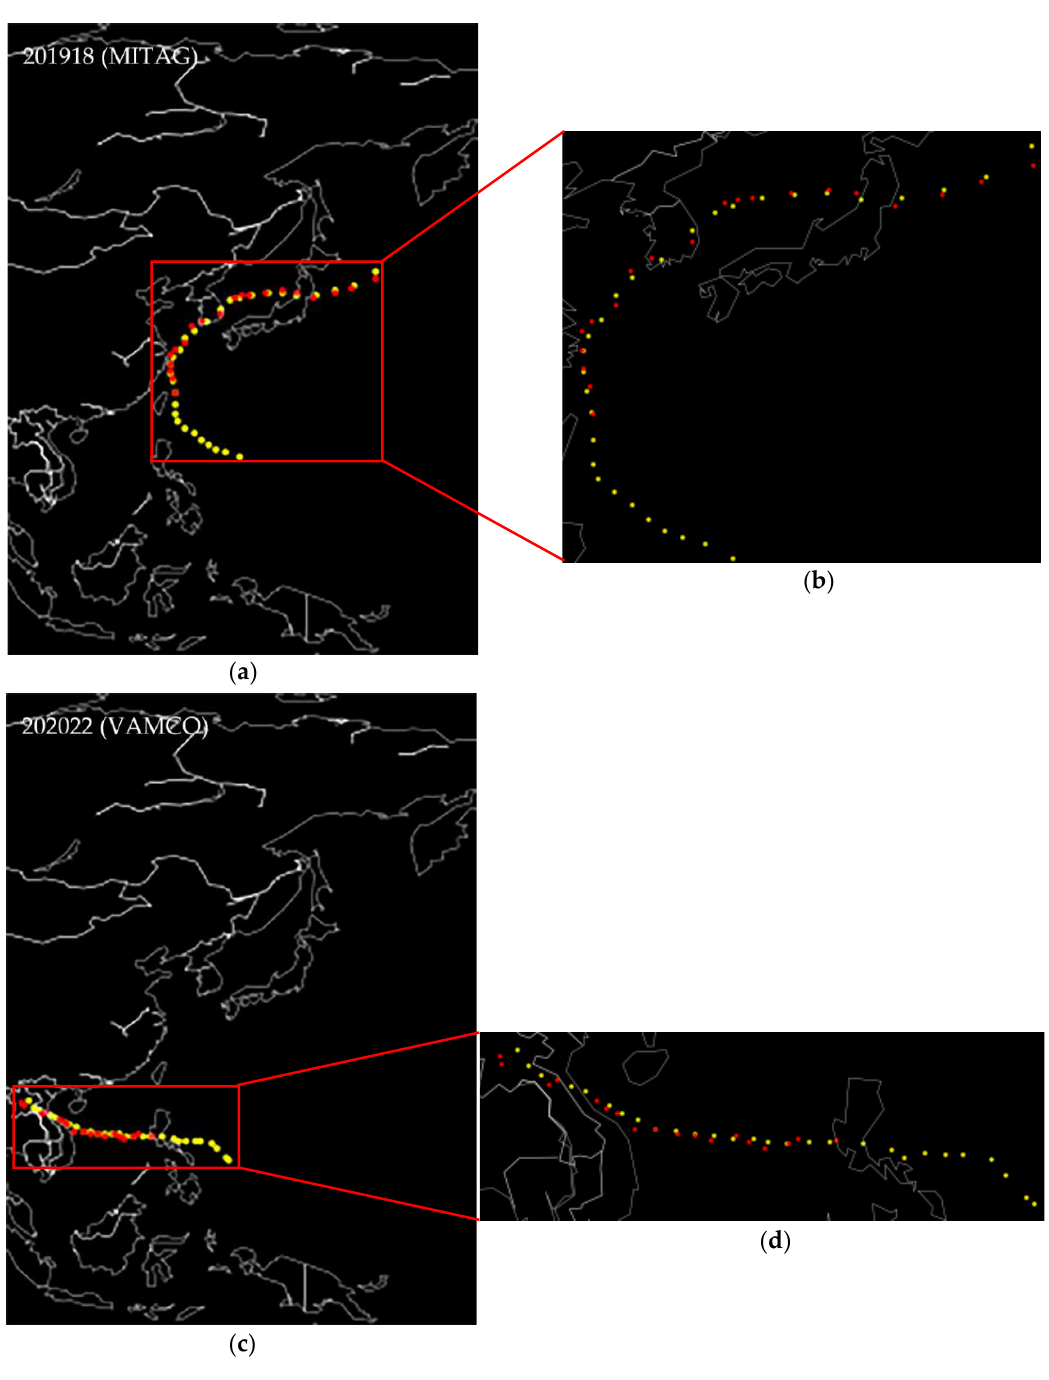
Figure 7. Diagrams comparing the predicted and real tracks of Typhoon MITAG and Typhoon VAMCO. ( a ) MITAG. ( b ) A partial enlargement of image ( a ). ( c ) VAMCO. ( d ) A partial enlargement of image ( c ).